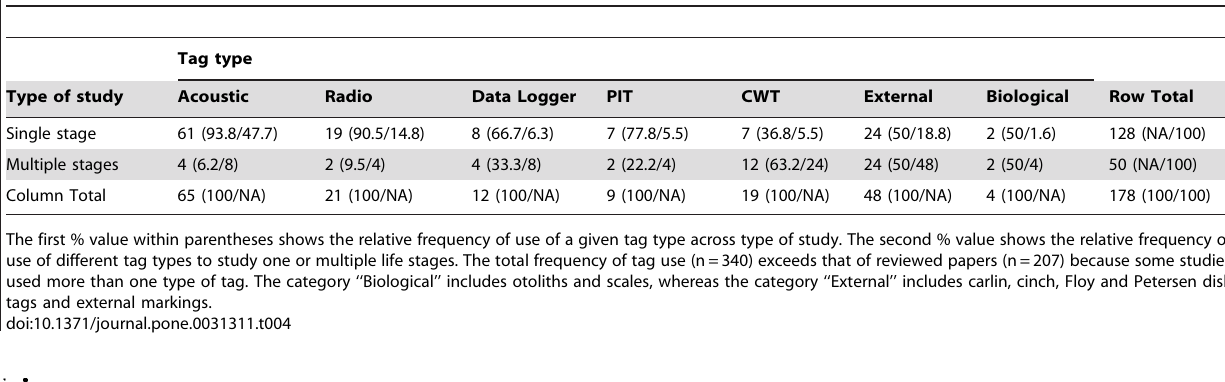
Table 4. Frequency (% within parentheses) of use of different tag types to study single and multiple life stages of anadromous salmonids in the marine environment for studies focusing on behaviour (i.e. those focusing on only behaviour and both on behaviour and